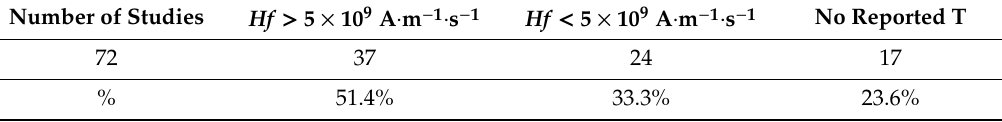
Table 1. Summary of the Hf product values of the studies addressed in this review. Number of